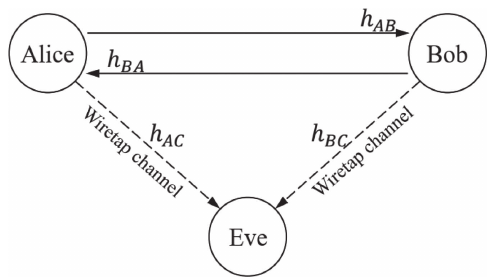
Figure 1. Three-node transmission and reception